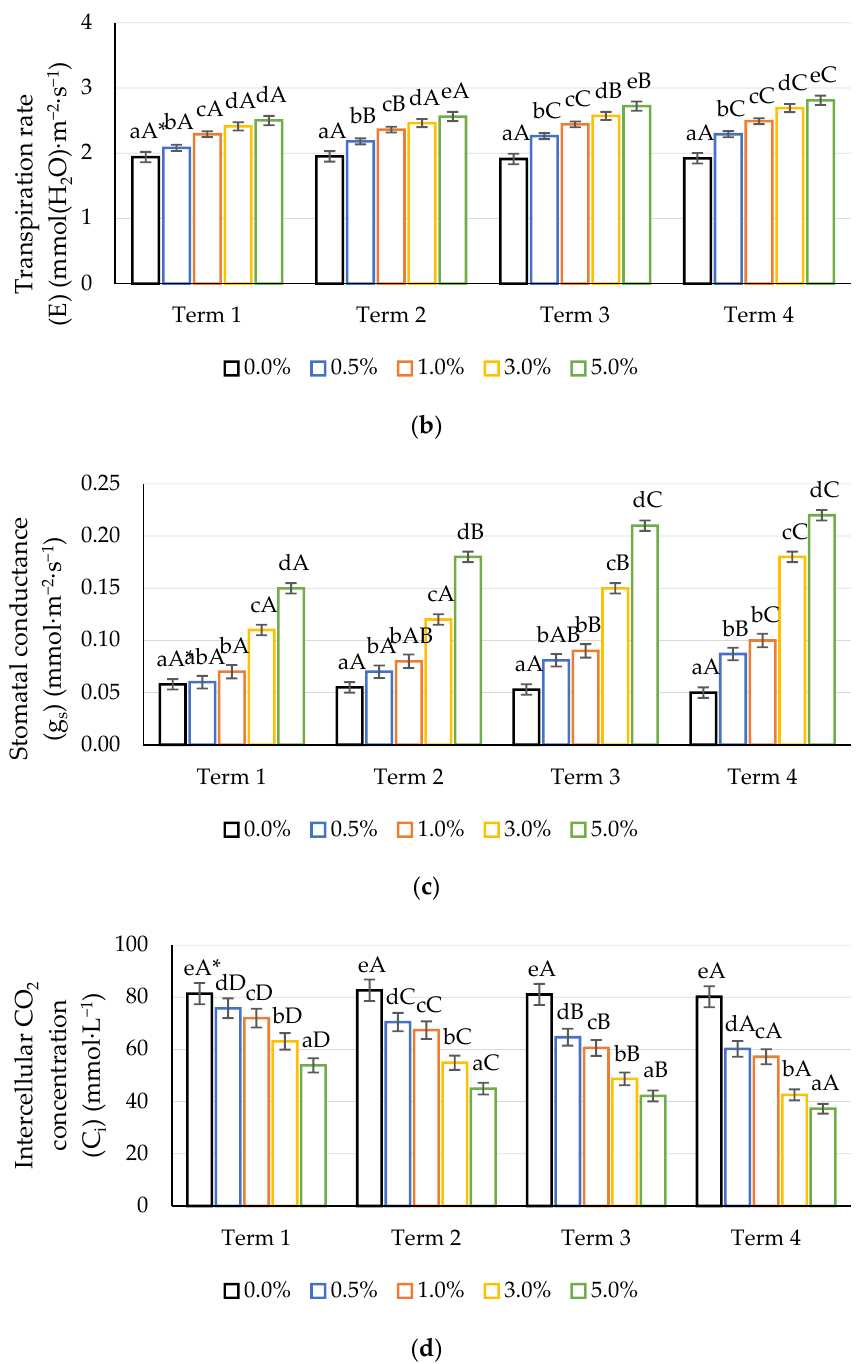
Figure 3. Impact of different aqueous concentrations of potassium quercetin derivative on maize gas exchange parameters: ( a ) net photosynthetic rate (P N ), ( b ) transpiration rate (E), ( c ) stomatal conductance (g s ), ( d ) intercellular CO 2 concentration (C i ). * Lowercase letters indicate significant differences between the means on respective measurement times, and capital letters indicate significant differences between means on the measurement times for respective potassium quercetin derivative concentrations and exposure times ( n = 20, p < 0.05).